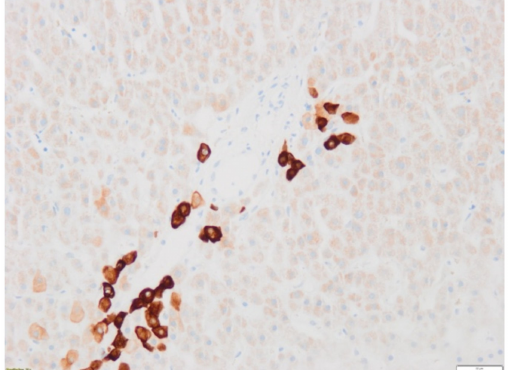
Figure 2. Second liver biopsy performed 5 weeks after cholestasis onset. Immunohistochemical staining with an anti-cytokeratin-7 (CK7) antibody. Large interlobular bile ducts are absent as anti-CK7 staining only reveals the ductular reaction. These findings are suggestive of